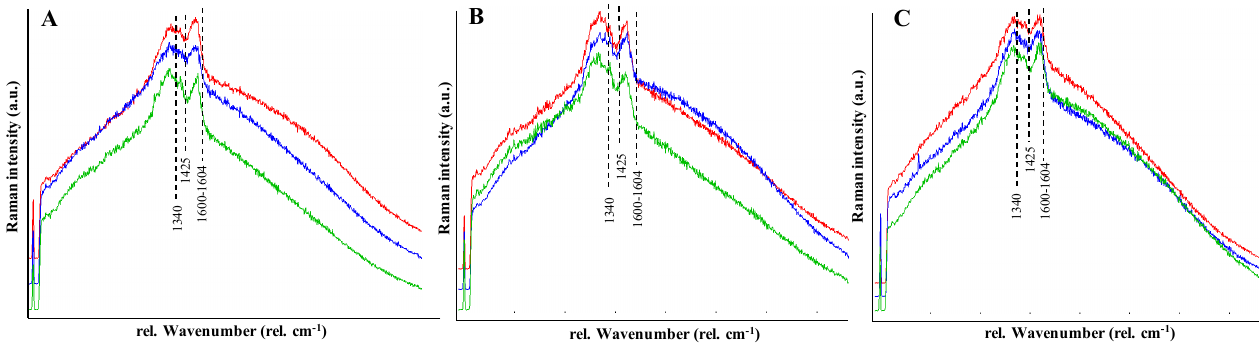
Figure 2. Raman spectra of melanin pigments of C. antarcticus grown on ( A ) OS exposed to space simulated conditions; ( B ) P-MRS and ( C ) S-MRS exposed Mars-like conditions on different layers: Top (exposed to sun light with 0.1% Neutral Density filters) = red spectrum, Bottom (dark control in space, not exposed to space radiation) = blue spectrum and Control (sample kept in the lab, in the dark at room temperature) = green spectrum. OS = Original Substrate, P-MRS = Phyllosilicatic Mars Regolith Simulant, S-MRS = Sulfatic Mars Regolith Simulant.